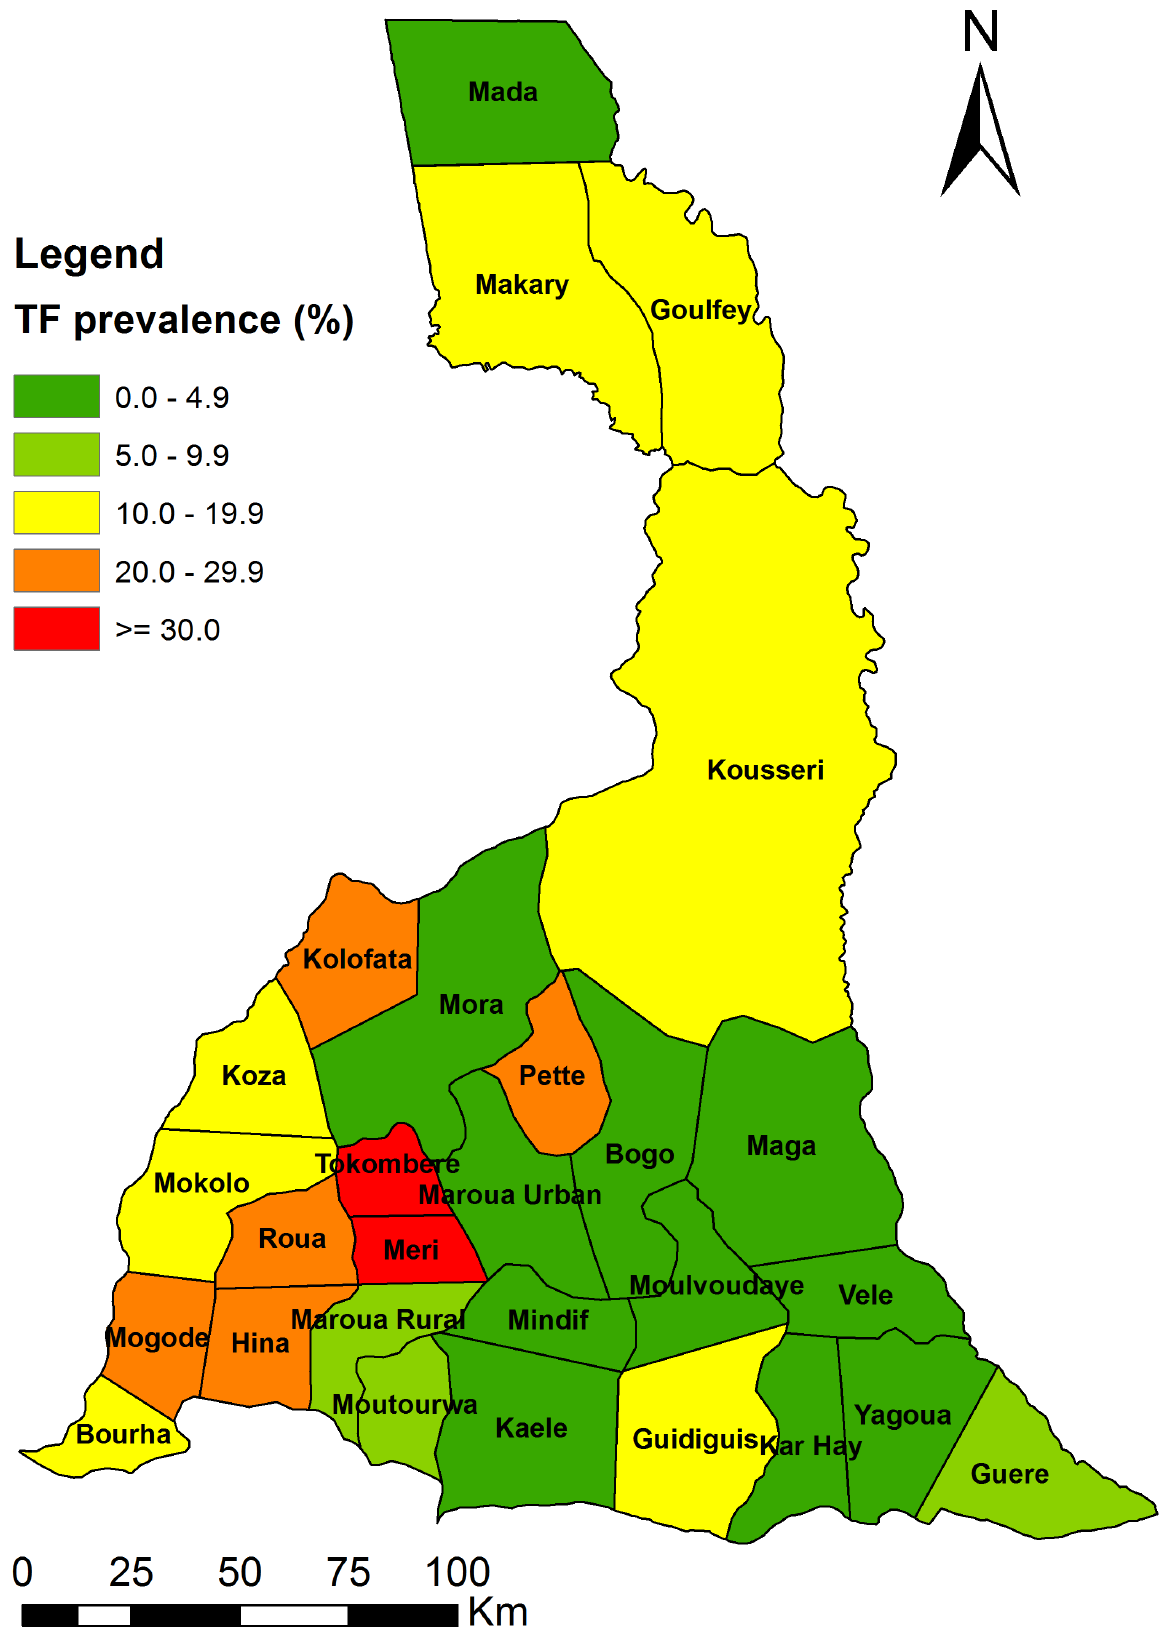
Figure 1. Distribution of TF prevalence in children aged 1–9 years in the Far North region.